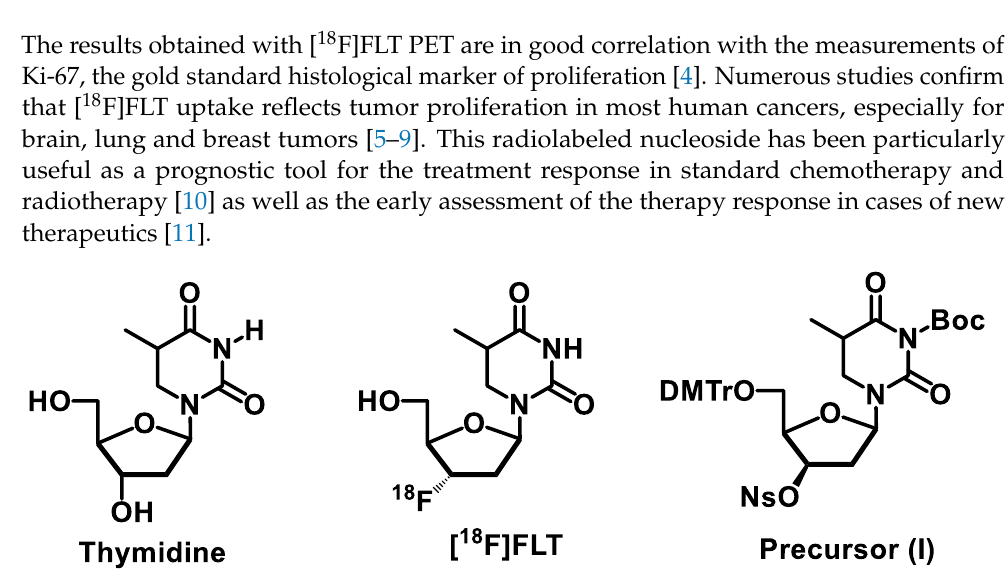
Figure 1. The structures of thymidine, [ 18 F]FLT and labeling precursor, 3- N -Boc- 5′ - O -dimethoxy- trityl- 3′ - O -nosyl-thymidine ( I ).